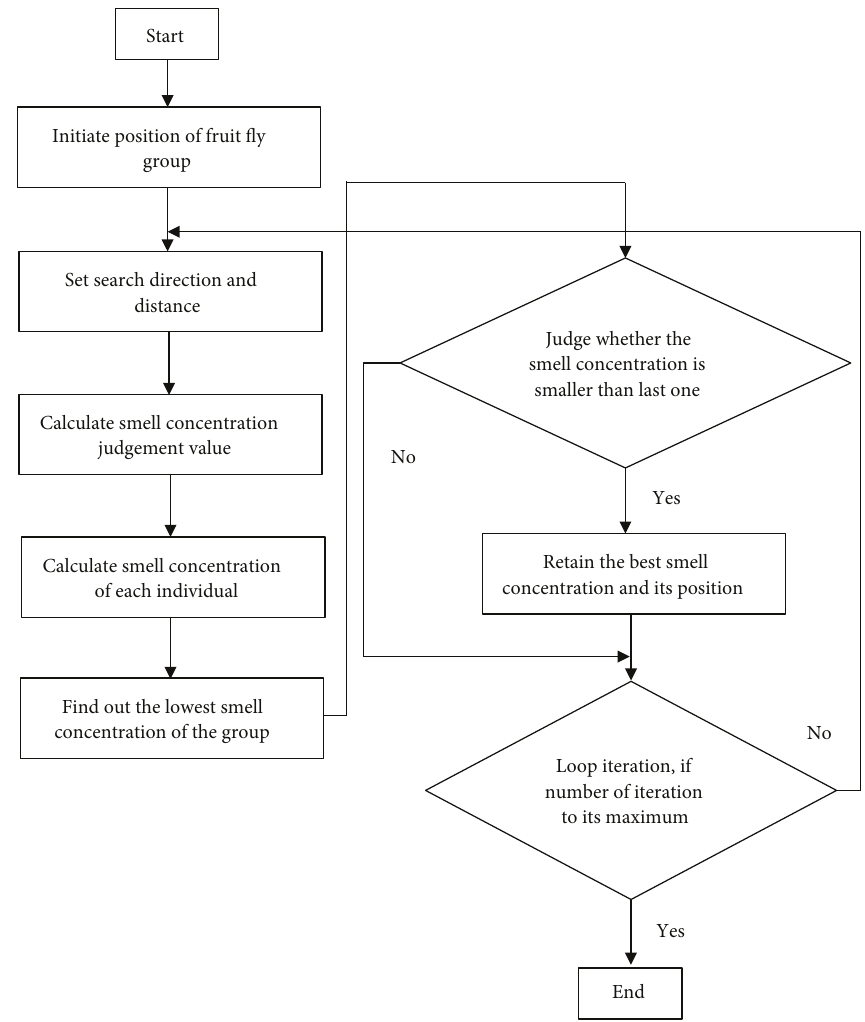
Figure 11: Fruit fly algorithm flow